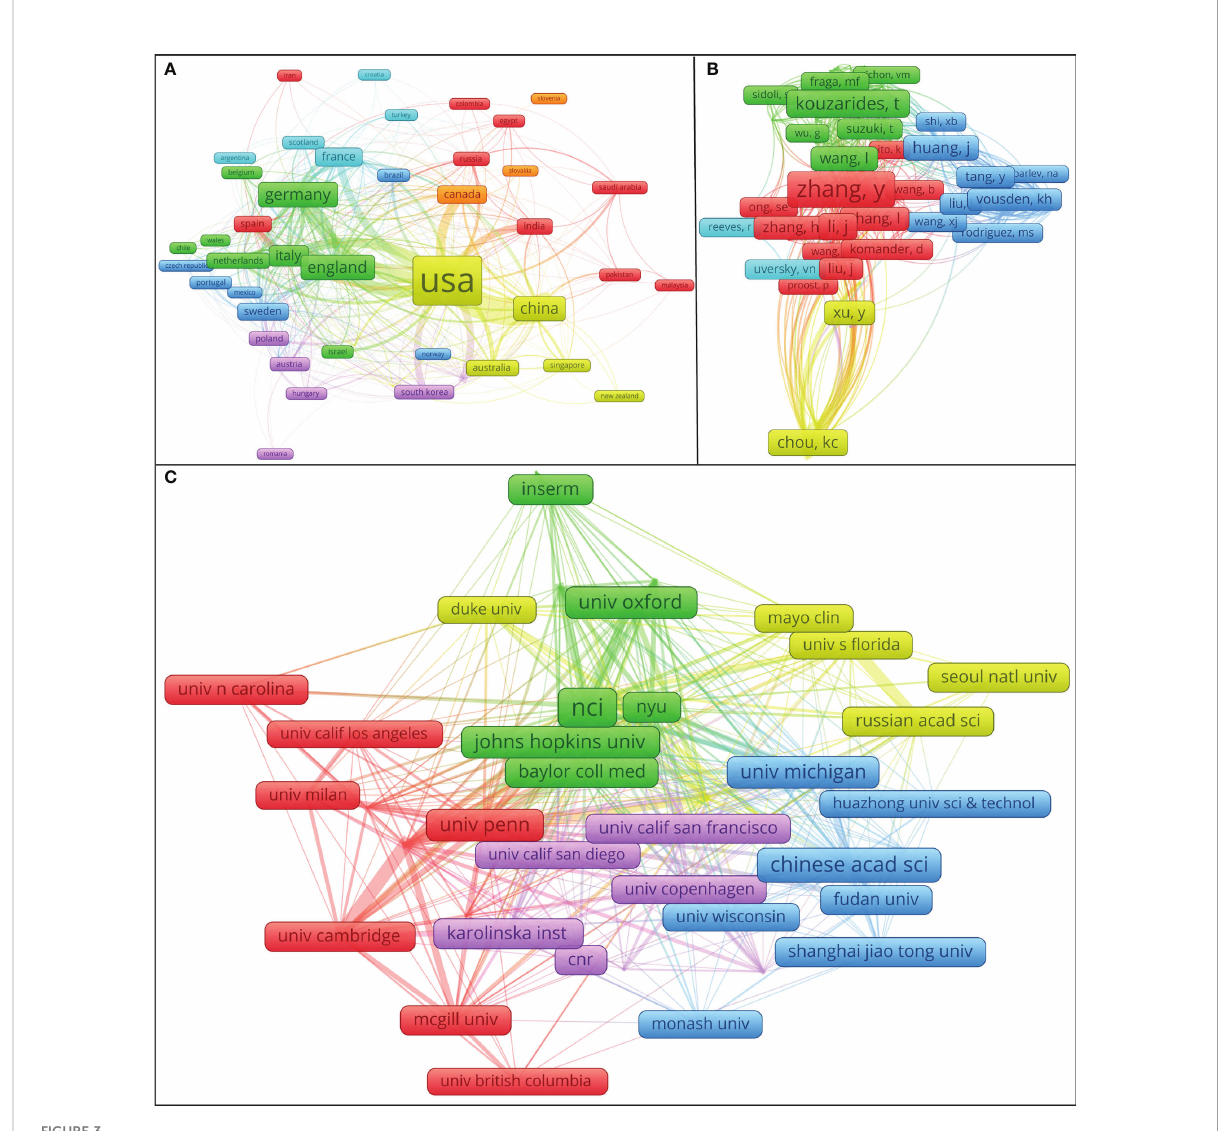
FIGURE 3 Cooperation maps between countries/regions, institutions, and the authors ’ co-citation network visualization map. Source: authors with VOSviewer. (A) The coupling of the country to which the literature belongs. Different colors show different clusters. The number of common references cited by the research in countries with the same color is more, the links between them are more frequent, and the research topics are more similar. (B) The authors ’ co-citation network visualization map. Nodes represent the frequency with which the author has been cited, the thickness of the lines re fl ects the co-citation strength. The authors with the same color may be a scienti fi c community. When the literature of two authors is cited by the literature of the third author at the same time, it is said that there is a co-citation relationship between the two authors; If the “ distance ” between two authors is closer, the higher their co-citation frequency is, the closer their academic relationship is. (C) The cooperation mapping between institutions. Different colors represent clusters with close cooperation. The thickness of the line between institutions re fl ects the frequency of the